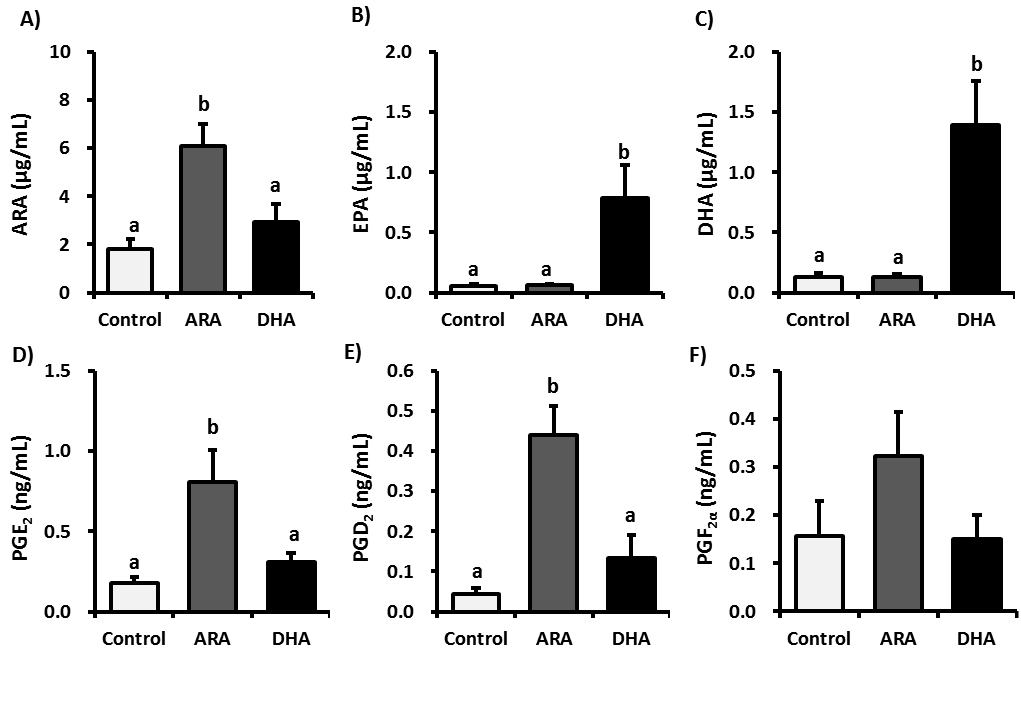
Figure 2. Plasma levels of free PUFAs and PGs in control, ARA, or DHA oil-treated rats. Plasma samples were subjected to LC-MS/MS lipidomic analysis. The graph presents the concentrations of: ( A ) ARA, ( B ) EPA, ( C ) DHA, ( D ) PGE rat plasma. The values are expressed as the mean ± S.E. ( n = 8). Samples were analyzed using a one-way ANOVA followed by a Bonferroni post hoc test. a, b Different letters indicate statistical differences at p <